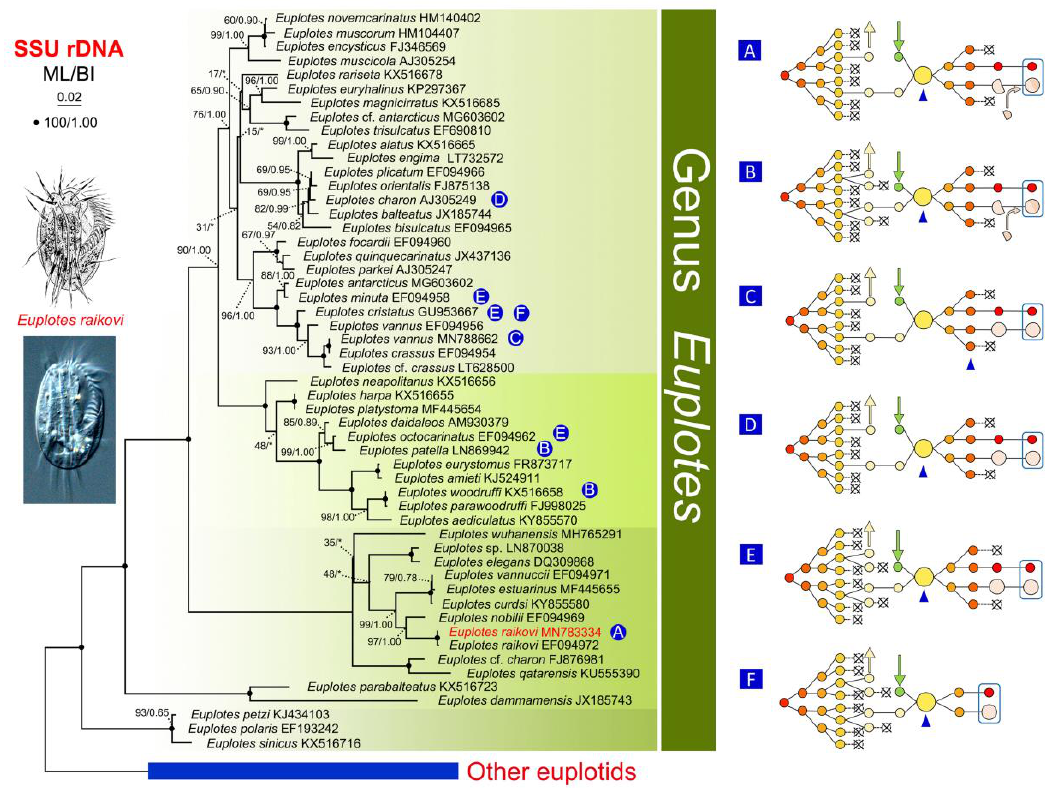
Figure 5. Maximum likelihood (ML) tree of the family Euplotidae based on SSU-rRNA gene sequences. Diophrys scutum (MQ603644) and Aspidisca aculeata (EF123704) were used as outgroup species. Numbers at nodes represent the bootstrap values of maximum likelihood (ML) out of 1000 replicates and posterior probability of Bayesian analysis (BI). Asterisk (*) indicates disagreement between ML and BI analyses. The scale bar corresponds to 5 substitutions per 100 nucleotide positions. ( A – F ) Different patterns of the nuclear events during conjugation in Euplotes species (reviewed from [23,24,27,28,33,49–51]). It is still unclear what roles the residual parental MAC plays in the development of the new